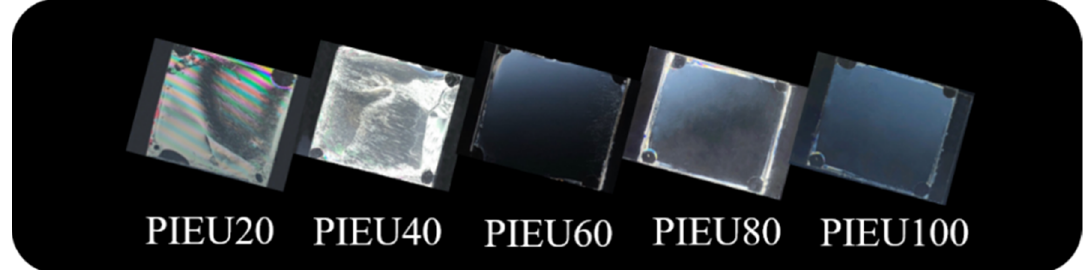
Figure 5. Photograph images of the LC cells made from PIEU# films according to the molar content of isoeugenol moiety.